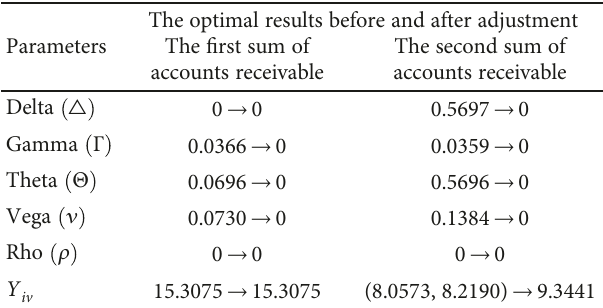
Table 13: Parameters of risk after